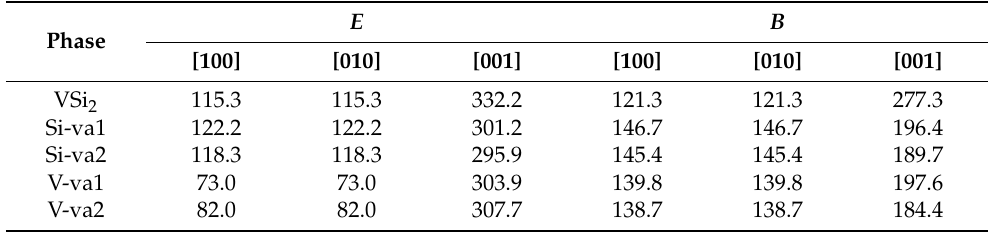
Table 6. Calculated directional elastic moduli in three principal directions (in GPa) of C11 b -VSi 2 .